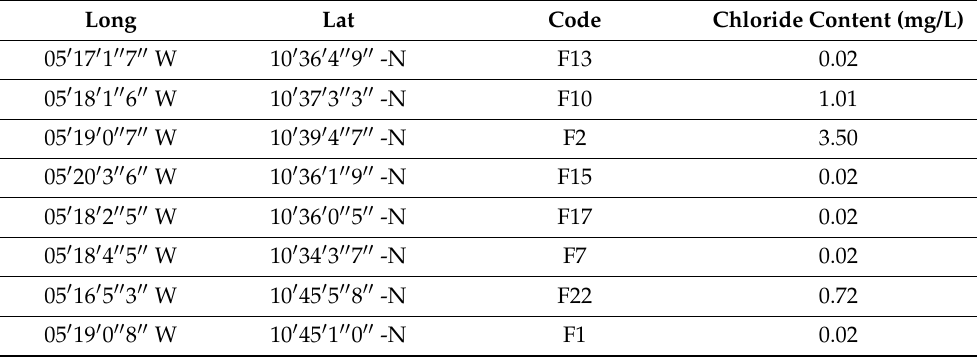
Table 4. Chloride contents in groundwater in the